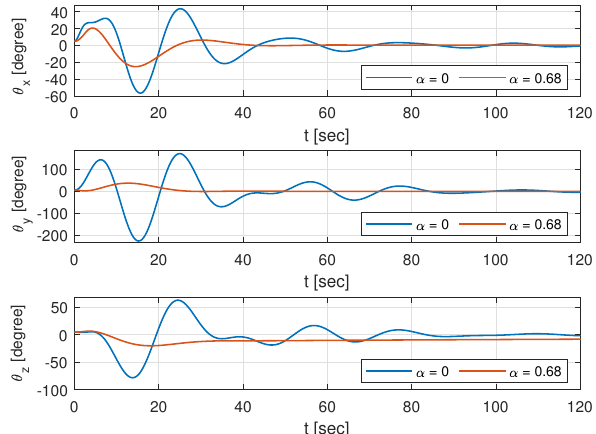
Figure 15. Angular position of the spacecraft with reduced settling time.